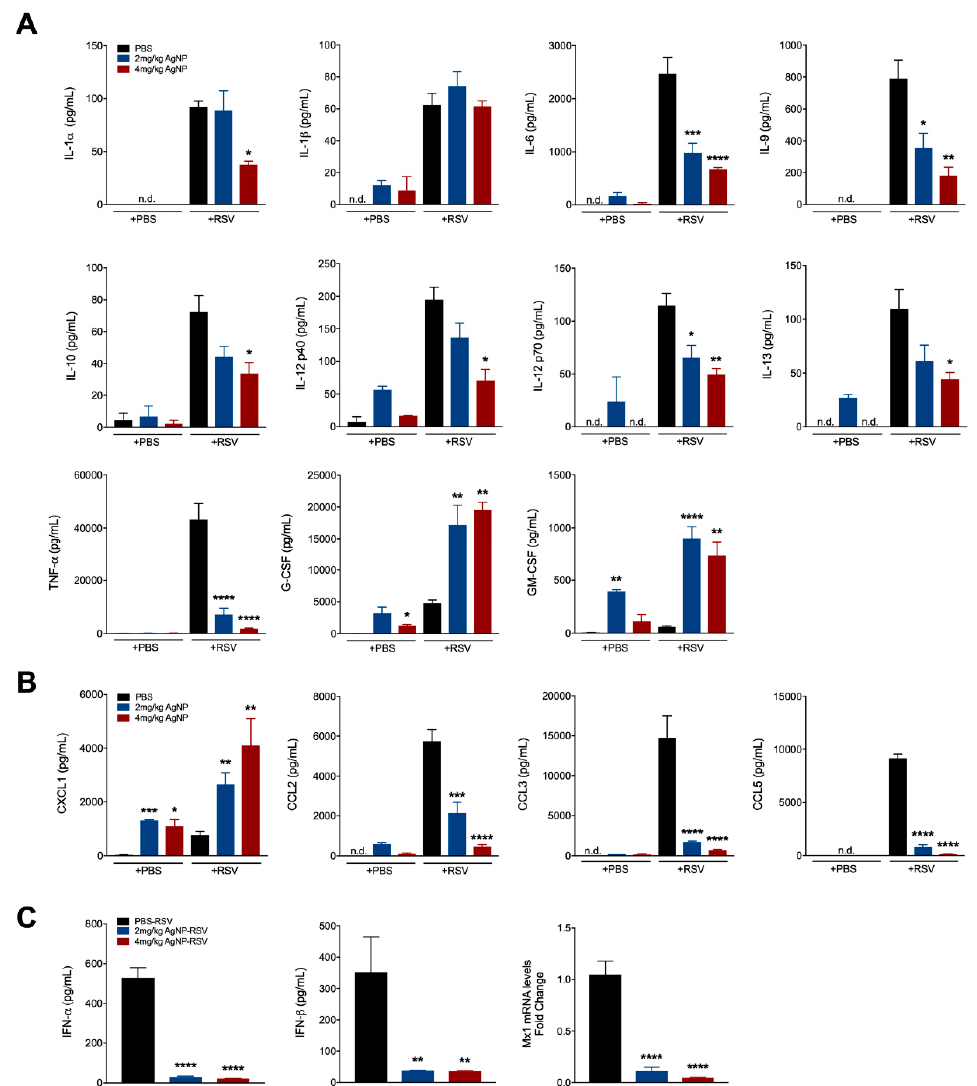
Figure 3. AgNPs decrease viral-induced cytokines, while increasing those associated with neutrophil recruitment and activation. BALF was collected at day one p.i. and analyzed for ( A ) cytokines, ( B ) chemokines and ( C ) type-I IFNs by Bio-plex, ELISA, and qRT-PCR analysis. Data are expressed as mean ± SEM (n ≥ 6 mice) and is representative of two independent experiments. Significant results as compared to the respective control are marked with asterisks (* for p ≤ 0.05, ** for p ≤ 0.01, *** for p ≤ 0.001, **** for p ≤ 0.0001). Not detected (n.d).